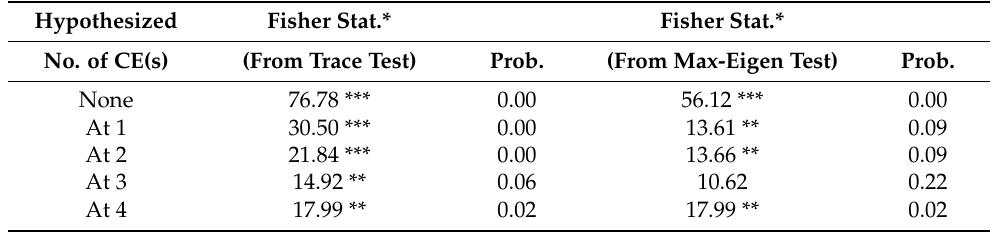
Table 4. Fisher co-integration